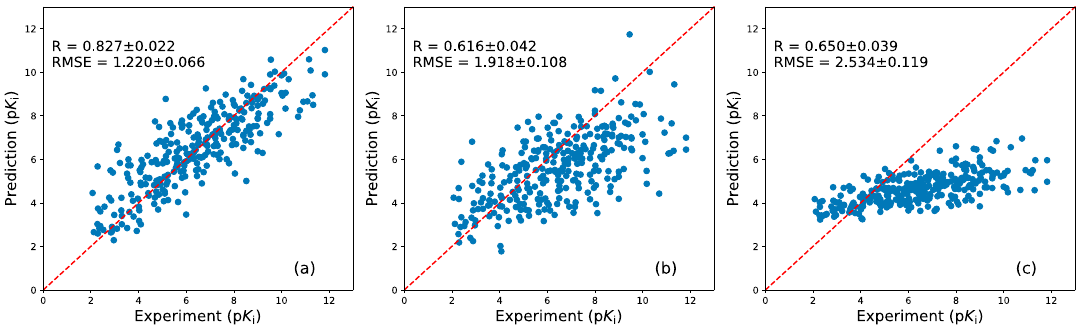
Figure 4. The scatter plots of the experimental binding affinities and prediction results obtained with ( a ) AK-score-ensemble, ( b ) Autodock-Vina, and ( c ) X-score are depicted. The predicted binding affinities in kcal/mol were converted to p K i to compare with the experimental binding affinities. The Pearson correlation coefficient and root-mean-squared-error (RMSE) value of the predictions and their uncertainties are estimated using the bootstrapping analysis.